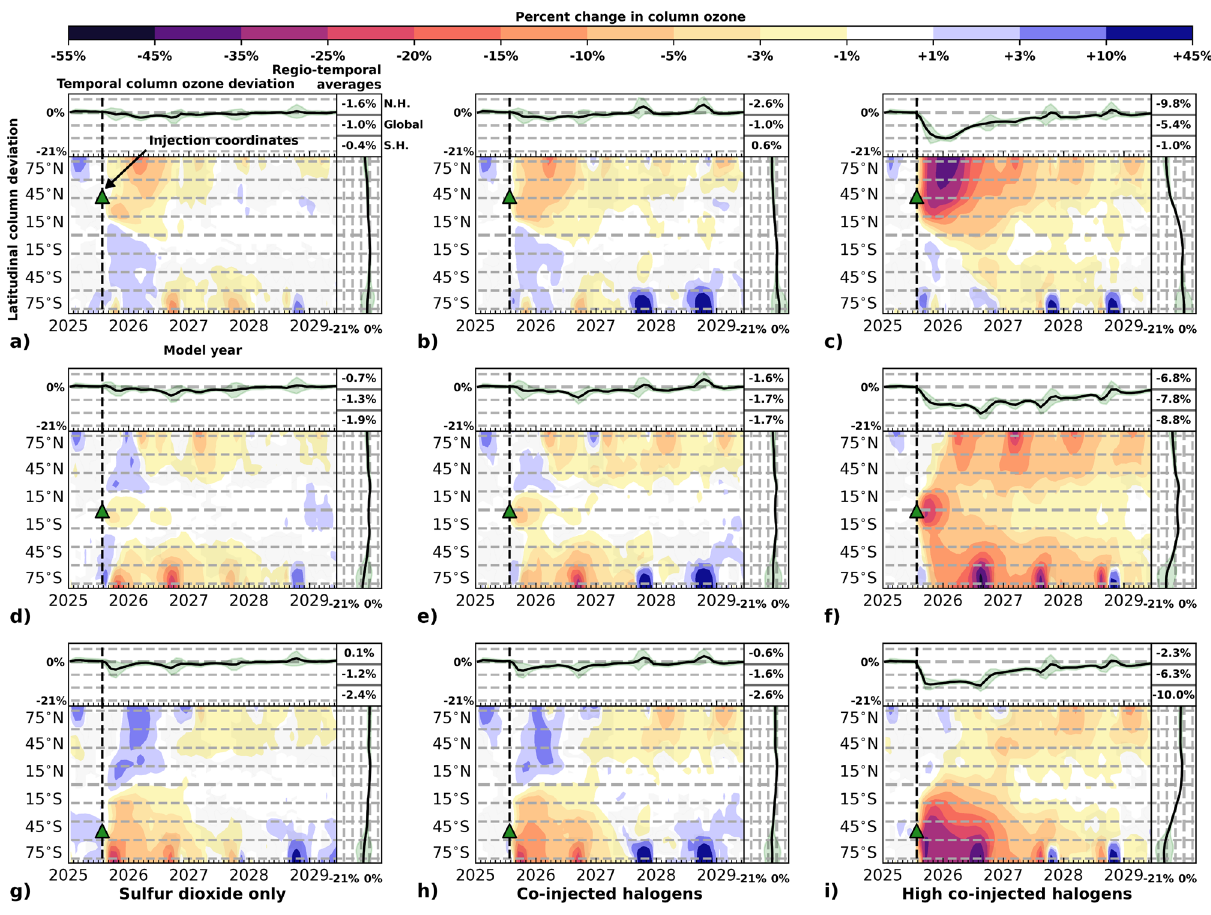
Figure 6. Ozone response to volcanic eruptions of varying halogen injection. Left column, panels ( a ), ( d ), and ( g ): Sulfur dioxide only eruptions in which volcanic SO 2 (5 Tg SO 2 ) is injected into the stratosphere. Center column, panels ( b ), ( e ), and ( h ): Intermediate co-injected halogen eruptions in which 5 Tg SO 2 , 0.05 Tg HCl, and 0.0005 Tg HBr are injected into the stratosphere. Right column, panels ( c ), ( f ), and ( i ): High co-injected halogen eruptions in which 5 Tg SO 2 , 0.5 Tg HCl, and 0.005 Tg HBr are injected into the stratosphere. Volcanic ◦ ◦ eruption scenarios (SSP3-70 July 25, 2025) are presented for three latitudes: ( a )–( c ) 42 N, ( d )–( f ) 1 S, and ◦ ( g )–( i ) 50 S. In all graphical panels, computed metrics reflect the difference between the eruption perturbation ensemble and the control ensemble with a 4-year time-horizon. Main, bottom left panels: Response of total column ozone in percent as indicated in the colorbar (note that colorbar levels increment non-linearly). Top left panels: Global average response of total column ozone over time as indicated in the left scale. Bottom right panels: Response of total column ozone average over time versus latitude. Green shading in the top left and bottom right panels illustrates variation (2 σ ) in the eruption perturbation ensemble; note that the increment between dashed lines in these panels is 7%. Top right corner panel: 3-year extra-polar hemispherical average ◦ ◦ ◦ ◦ ◦ ◦ (0 –80 N and 0 –80 S) and global average (80 S–80 N) of the total column ozone deviation, ordered as NH, Global, SH. Panels ( a )–( i ): Latitude and date of SO 2 and halogen injection are indicated by a green triangle and a dashed